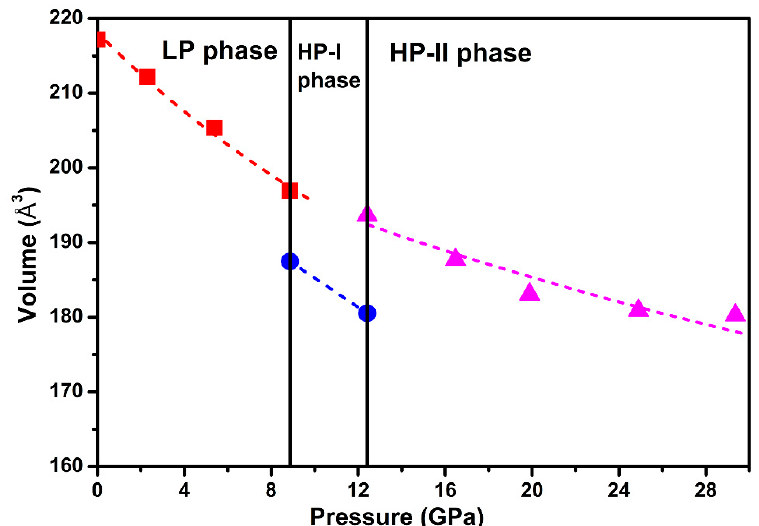
Figure 6. Room-temperature equation of state data for Ag 2 S nanosheets. A third-order Figure6. Room-temperatureequationofstatedataforAg 2 Snanosheets. Athird-orderBirch-Murnaghan Birch-Murnaghan (BM) equation of state (EOS) is introduced to fit our pressure-volume data. (BM) equation of state (EOS) is introduced to fit our pressure-volume data.